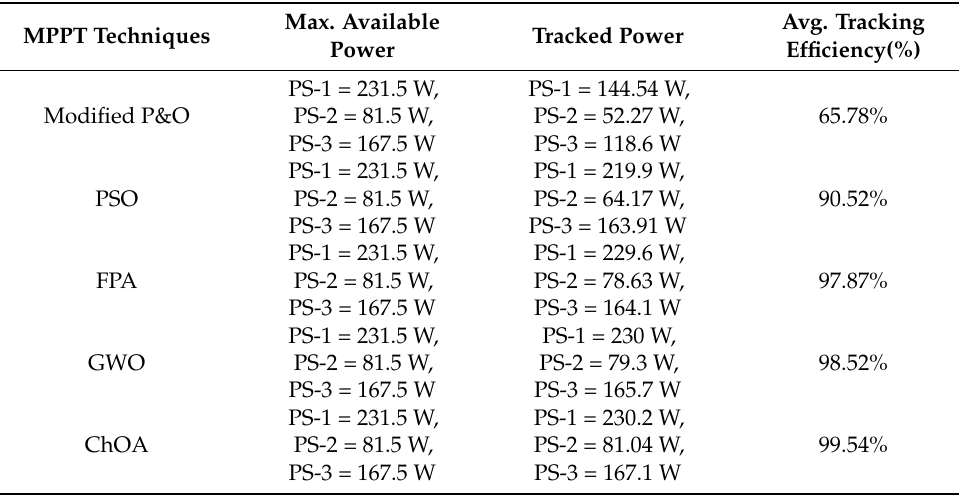
Figure 16. GMPP tracking performance of different MPPT methods. Table 4. Performance comparison of various MPPT